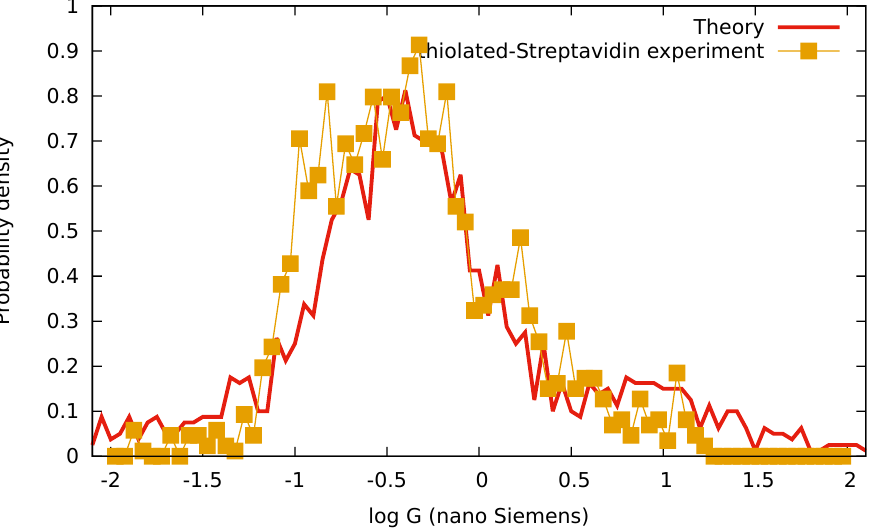
Figure 4. Comparison of measurement data from Figure 4A of [6] (yellow points) and our simulation (red line). Horizontal axis is logarithmic and conductance is in units of